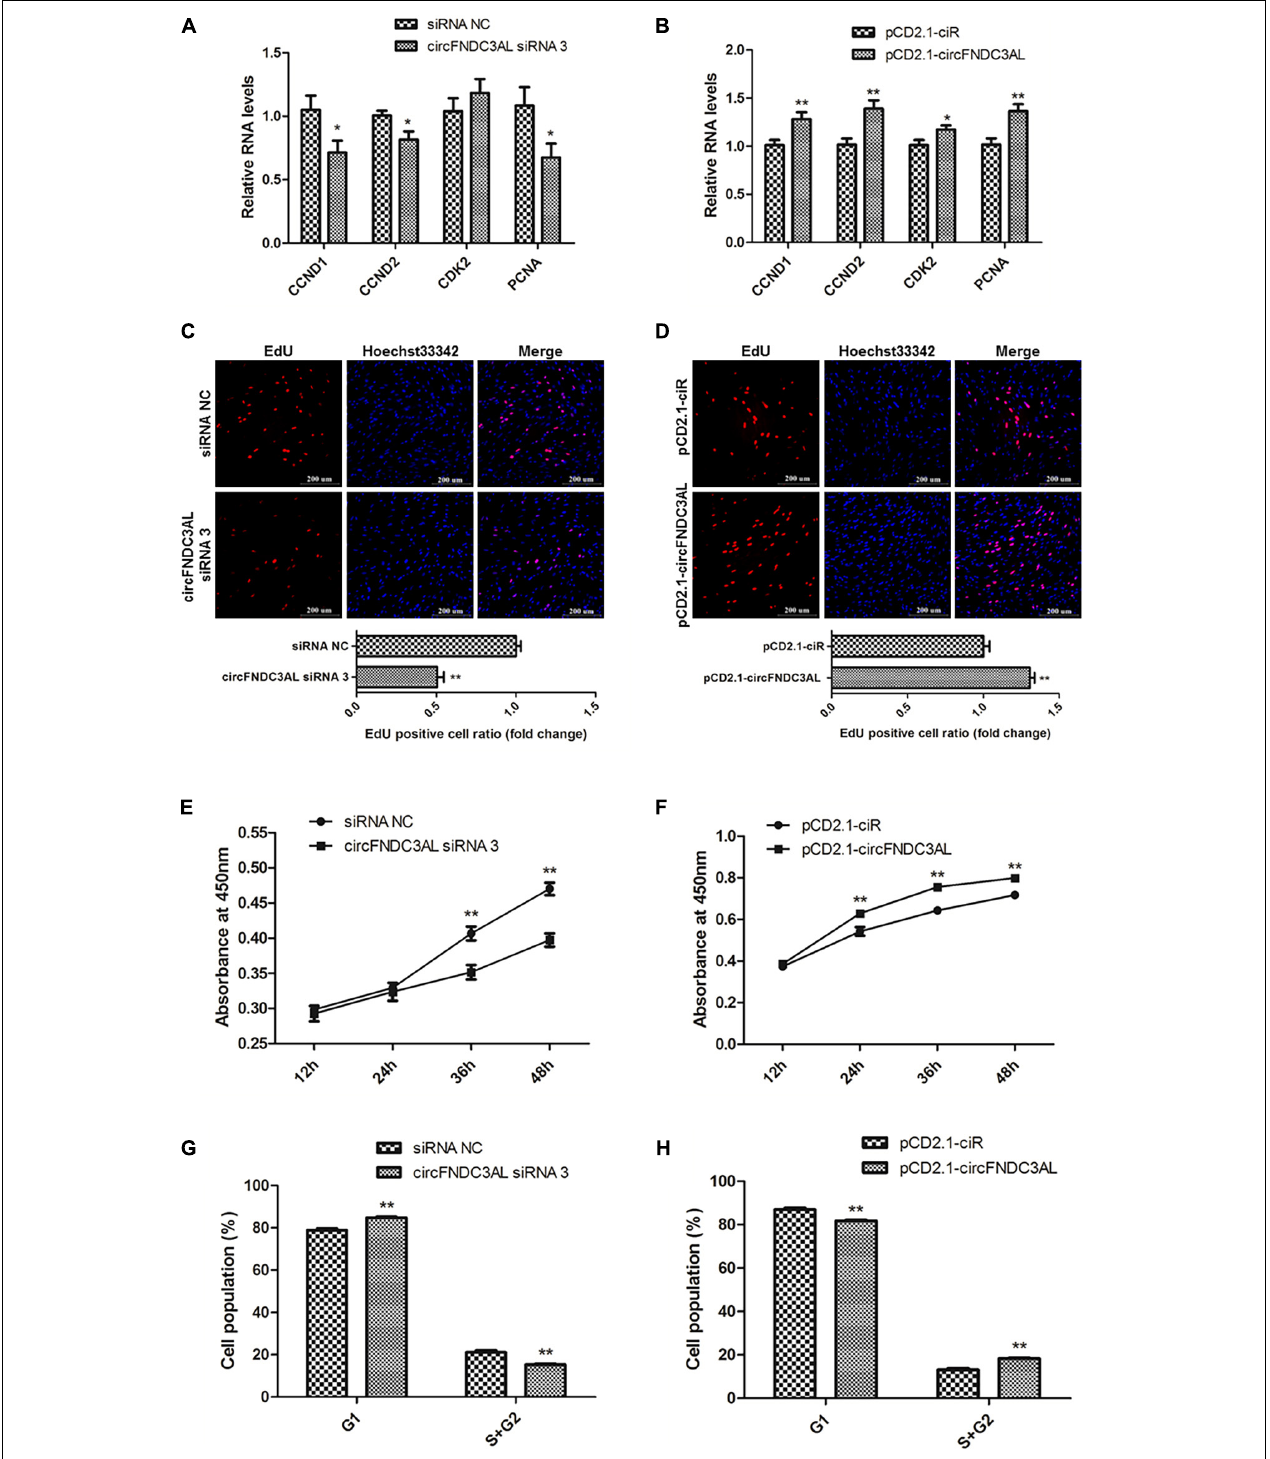
FIGURE 2 | CircFNDC3AL promotes the proliferation of SMSCs in chicken. (A,B) Proliferation-related genes mRNA levels were determined using qPCR after SMSCs were transfected with circFNDC3AL siRNA or overexpression plasmid. (C,D) EdU assays were conducted after the cells were transfected with circFNDC3AL siRNAs or vectors. (E,F) SMSCs absorbance at 450 nm was detected by CCK-8 assay after the cells were transfected with circFNDC3AL siRNAs or vectors. (G,H) Cell cycle analysis of SMSCs following circFNDC3AL overexpression or inhibition. The scale bar represents 200 µ m. Values represent as means ± S.E.M. of three biological replicates. * P < 0.05; ** P <